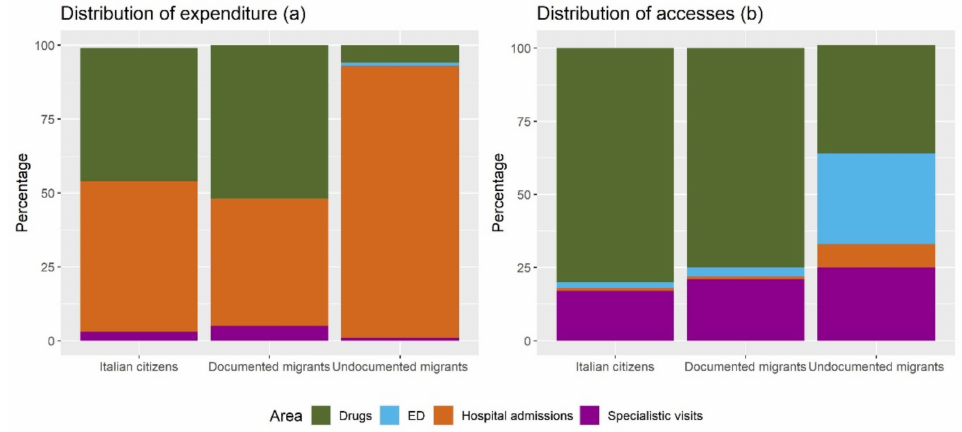
Figure 1. Distribution of expenditure ( a ) and accesses ( b ) for different healthcare services, grouped by